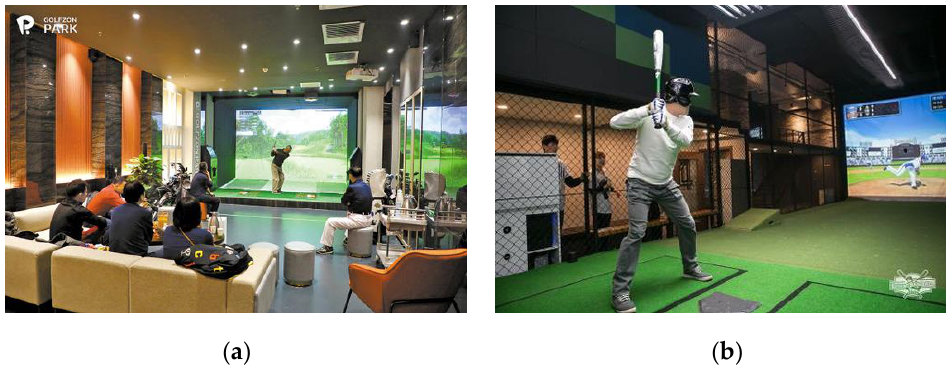
Figure 2. Screen golf ( a ) and baseball ( b ) facilities. Source: https://www.joongang.co.kr/article/24018948#home (24 March 2021) ( a ), https://www.segye.com/newsView/20180701002828 (2 July 2018) ( b ).